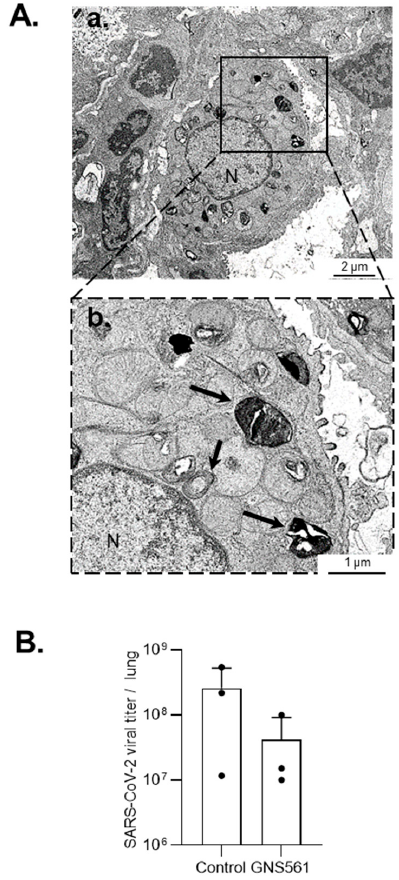
Figure 3. In vivo antiviral activity of GNS561. ( A ) Electron microscopy images of lung tissue from K18 hACE2 mice treated 24 h with GNS561 before SARS-CoV-2 infection and then treated daily with 50 mg/kg GNS561 compound and euthanized 7 days post-infection. Autophagic vacuoles are associated with MLBs (black arrow). ( B ) Lung viral titers from K18-hACE2 transgenic mice treated or not with GNS561 were investigated at 7 days post-infection by RT–qPCR. Three individuals were analyzed per